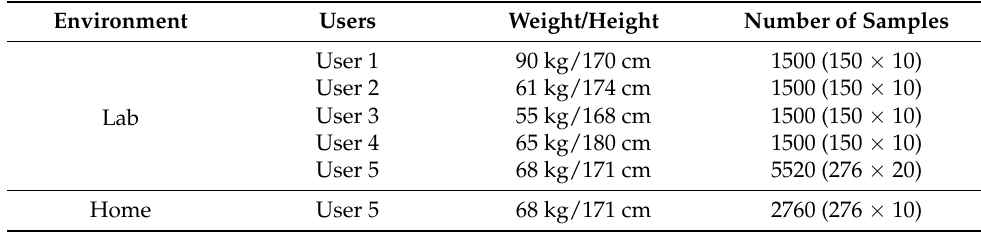
Table 2. The SignFi data collection